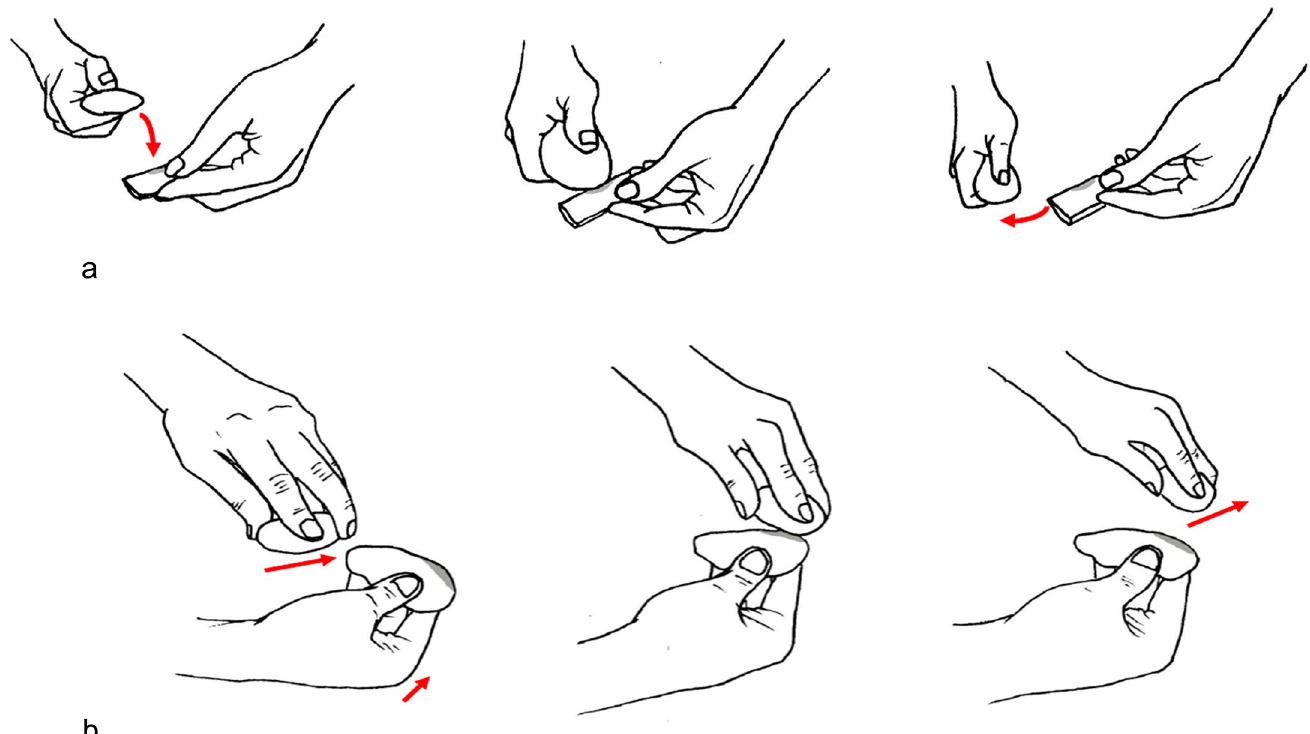
Fig 5. Schematization of the gestures used during the retouching experimental activity. (a) The marginal and abrupt retouch: a rapid and consequential gesture was performed. The knapper’s arm moved following an oblique dragging trajectory against the blank’s edge, striking it very quickly using the tool’s flat face along the apical area; (b) the scaled retouch: this action followed a perpendicular trajectory, with respect to the blank edge, with a movement from the top to the bottom of the arm and a final flexion downwards(drawings by Giulia Formichella).